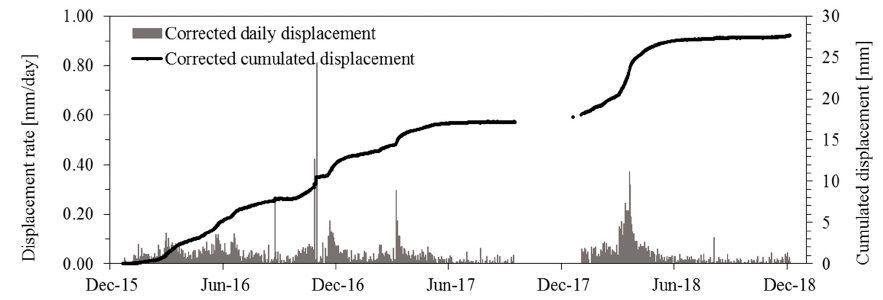
Figure 7. Corrected cumulated displacement and daily displacement from A11 in-place probes.